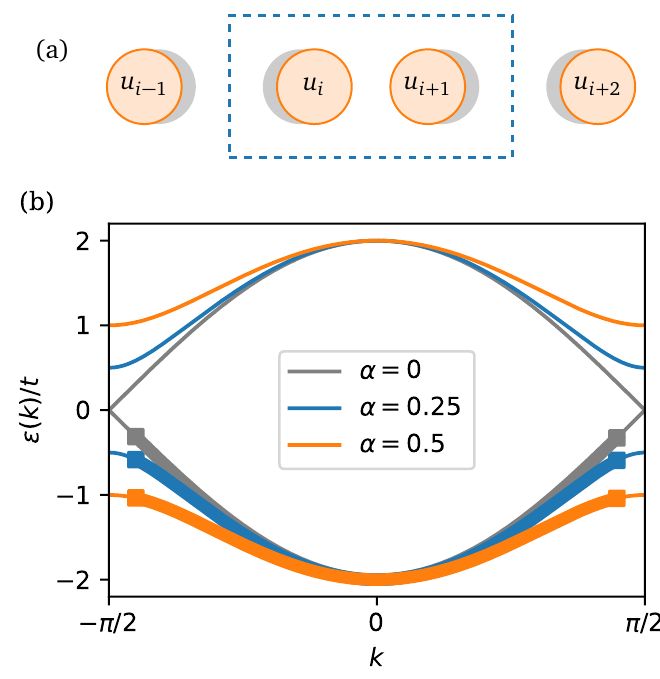
Figure 1: (a) Dimerization. (b) Band structure at various values of the atomic displacement α . The thick lines represent the occupied states when there are 〈 n 〉 = 0.9 spinless electrons per